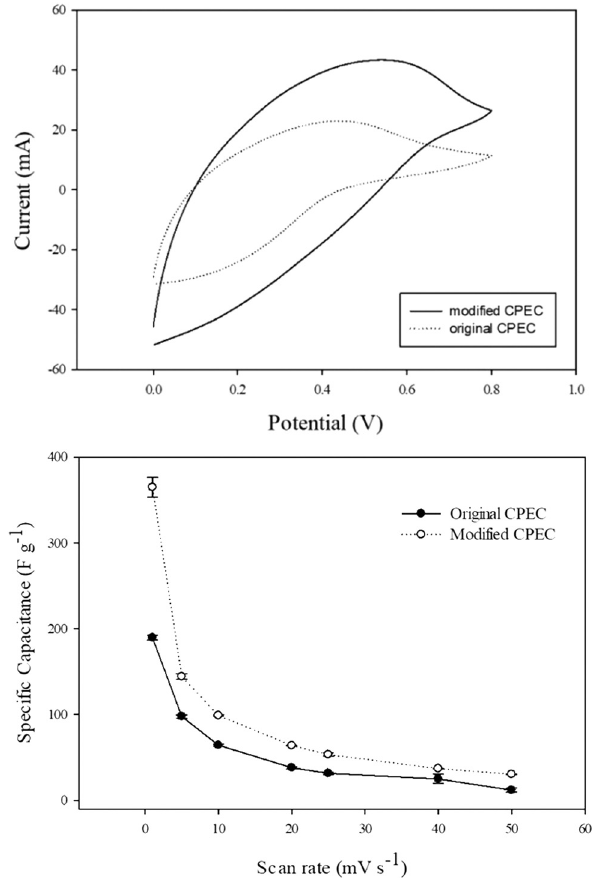
Figure 6: ( up ) Cyclic voltammogram of the original CPEC with 60% PANI loading and the modi fi ed CPEC at scan rate of 50 mV s − 1 . ( down ) Plots of speci fi c capacitance versus scan rate comparing original CPEC with 60% PANI loading and the modi fi ed